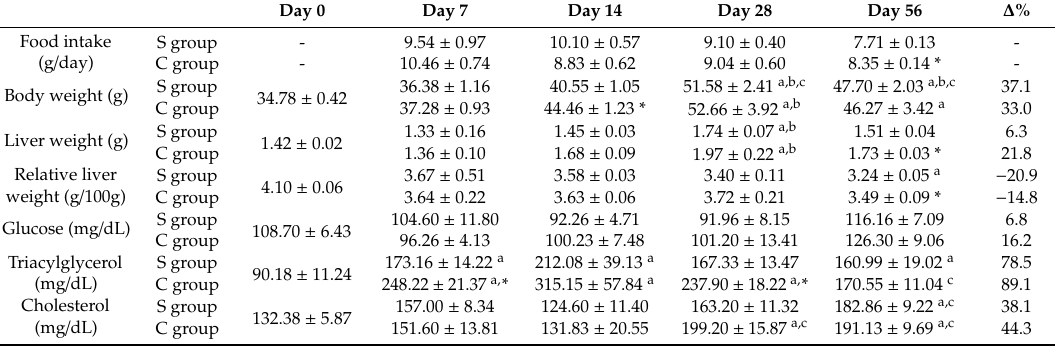
Table 2. Food intake, body weight, liver weight, relative liver weight, serum glucose, triacylglycerol, and cholesterol, of mice fed with a diet containing soybean oil (S group) or canola oil (C group) as a lipid source, at 0, 7, 14, 28, or 56 days after starting the diets.